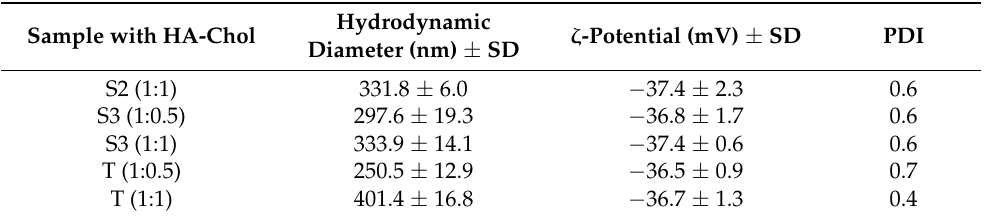
Table 2. DLS analyses of HA-Chol-coated Span and Tween niosomes. Values represent the mean ± standard deviation of n = 3 sample